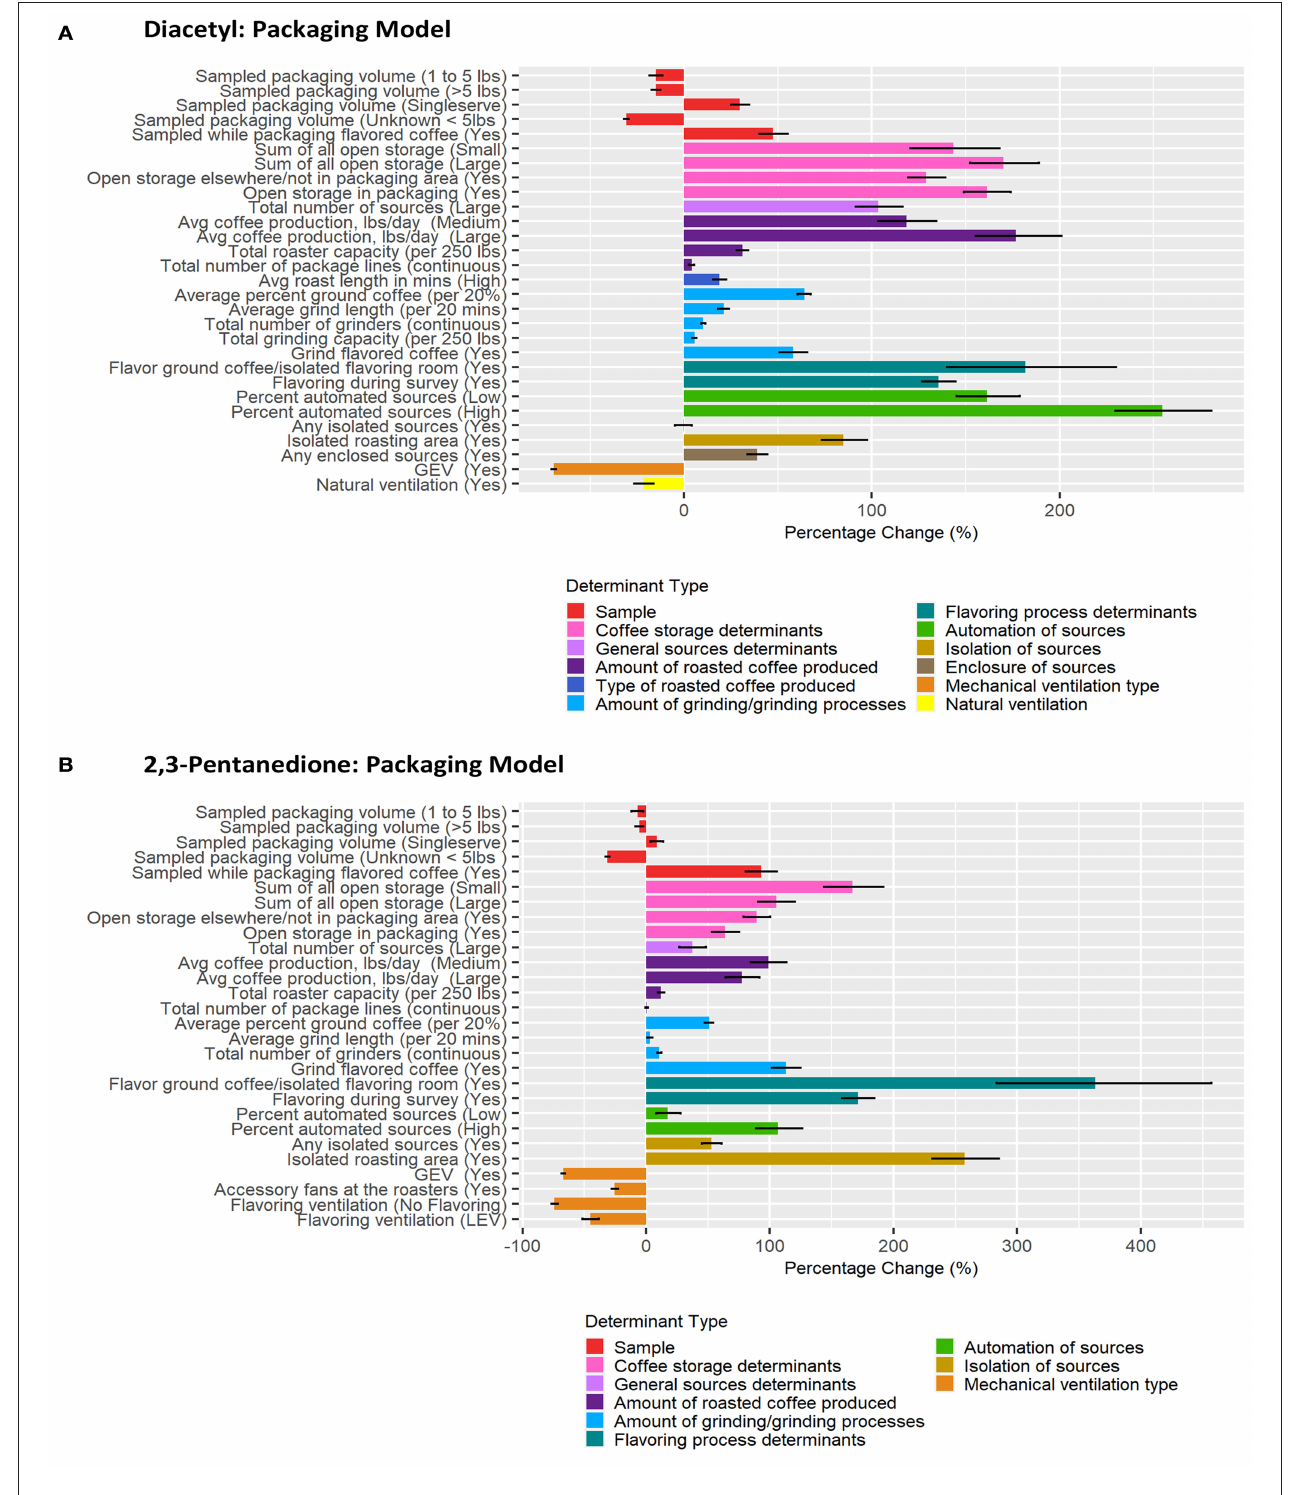
FIGURE 6 | Bar chart of percent change in diacetyl (A) and 2,3-pentanedione (B) exposures during packaging tasks compared with reference category or per unit change. Each bar represents the estimated percent change for the median posterior estimate with error bars for the 95% credible intervals. Percent change for continuous variables defined as per 1 unit with the exceptions of the following: total roaster capacity and total grinder capacity are calculated per 250 lbs, average percent ground coffee is calculated per increase in 20%, and average grind length in minutes is calculated per 20min.